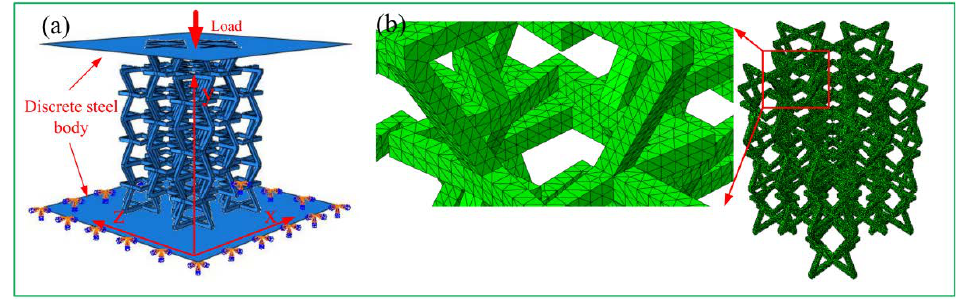
Figure 11. Establishment of a finite element model: ( a ) payload application; ( b ) grid division.